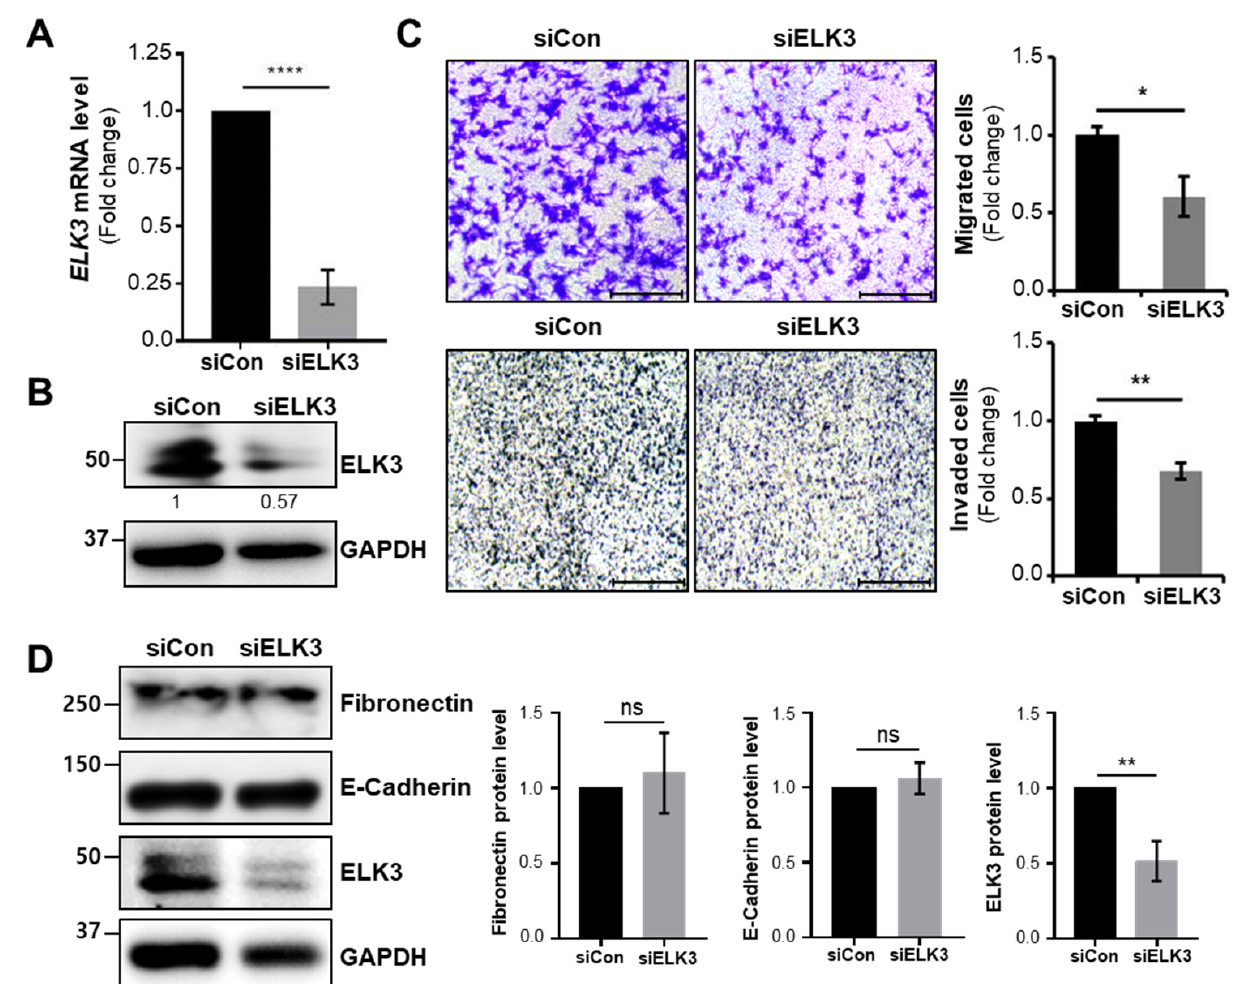
Figure 3. Depletion of ELK3 decreases the migration and invasion of SNU638 cell line in E-cadherin independent manner. ( A ) ELK3 mRNA levels in SNU638 cells transfected with siCon or si ELK3 . Error bars represent the standard deviation; **** p < 0.0001 (student’s t -test). ( B ) ELK3 protein levels in SNU638 cells transfected with siCon or si ELK3 . The values indicate the signal intensities of ELK3 relative to GAPDH. ( C ) Representative images showing cell migration (top two panels) and cell invasion (bottom two panels) of SNU638 cells transfected with siCon or si ELK3 . Scale bar, 200 µ m. Bar graphs indicate the number of migrated and invaded cells, respectively. Error bars represent the standard deviation; * p < 0.05 and ** p < 0.01 (student’s t -test). ( D ) Epithelial marker (E-cadherin), mesenchymal marker (Fibronectin), and ELK3 protein expression in SNU638 cells transfected with siCon or si ELK3 . Bar graphs indicate the quantified levels of each protein, in relative scales. Error bars represent the standard deviation; ** p < 0.01 (student’s t -test). ELK3, ETS transcription factor ELK3; si, small interfering RNA; Con, control.